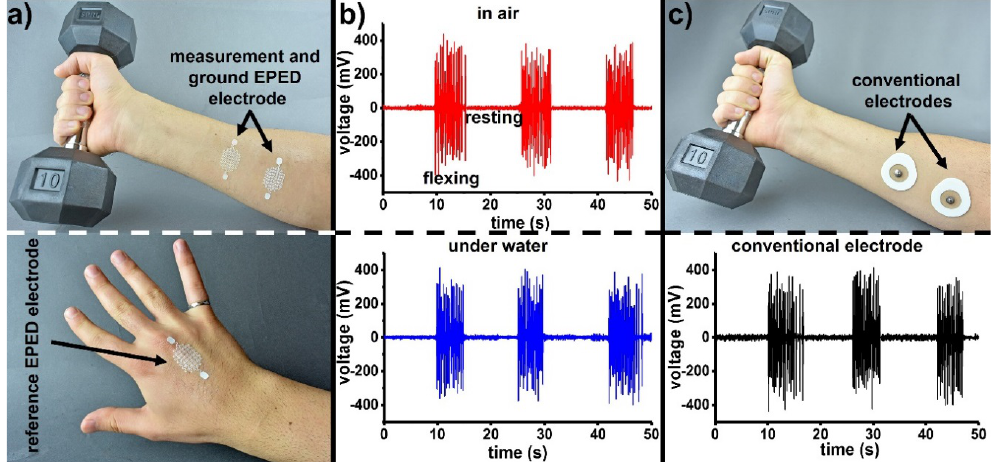
Figure 4. Comparison between the performance of razor printed EPEDs and conventional foam electrodes to monitor EMG signals: ( a ) Top: EPED measurement and ground electrodes used to record EMG signals from the forearm of an exercising subject. Bottom: Reference EPED electrode; ( b ) Top: EMG signals recorded in air using razor printed EPEDs. Bottom: EMG signals recorded under water; ( c ) Top: conventional foam electrodes placed at the same locations of the forearm as ( a ). Bottom: EMG signals recorded in air using conventional foam electrodes.